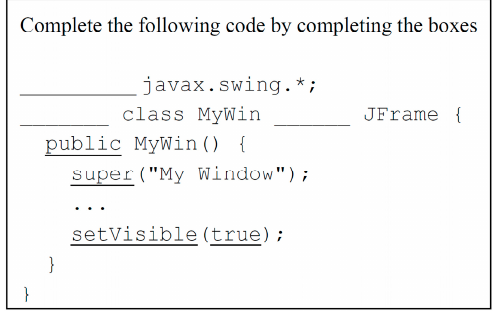
Figure 7. Complete the code: understanding keywords in context